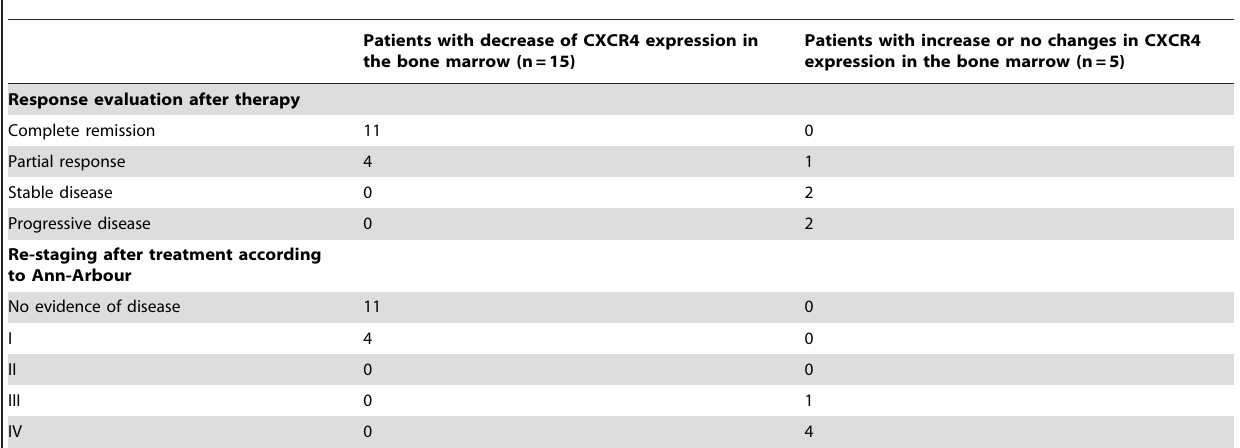
Table 2. Response evaluation and re-staging of lymphoma patients after therapy in relation to bone marrow CXCR4 expression